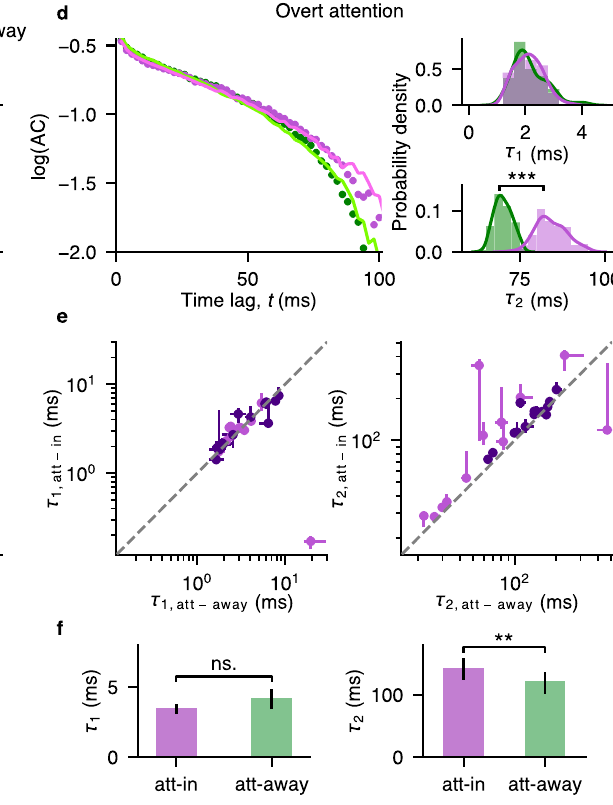
Fig. 3 | Slow timescales increase during spatial attention. a Autocorrelations (ACs) of neural data with two-timescale fi ts (left) and the corresponding posterior distributions (right) during covert attention and attend-away condition for an example recording session. The fi tted lines are autocorrelations of synthetic data from the two-timescale model with MAP parameters. The posterior distribution of the slow timescale ( τ 2 ) has signi fi cantly larger values in attend-in (att-in) than in attend-away (att-away) condition. Statistics: two-sided Wilcoxon rank-sum test, p τ =0 : 43, p τ <10 (cid:2) 10 . Number of samples in each posterior N =100. b The increase 1 2 of the slow timescale ( τ 2 , right) during attention was visible on most sessions (points - MAP estimates for individual sessions, error bars - the fi rst and third quartiles of the marginal posterior distribution, dashed line - the unity line). If the MAP estimate was smaller than the fi rst or larger than the third quartile, the error barwasdiscarded.Largererrorbarsindicatewiderposteriors,i.e.largerestimation